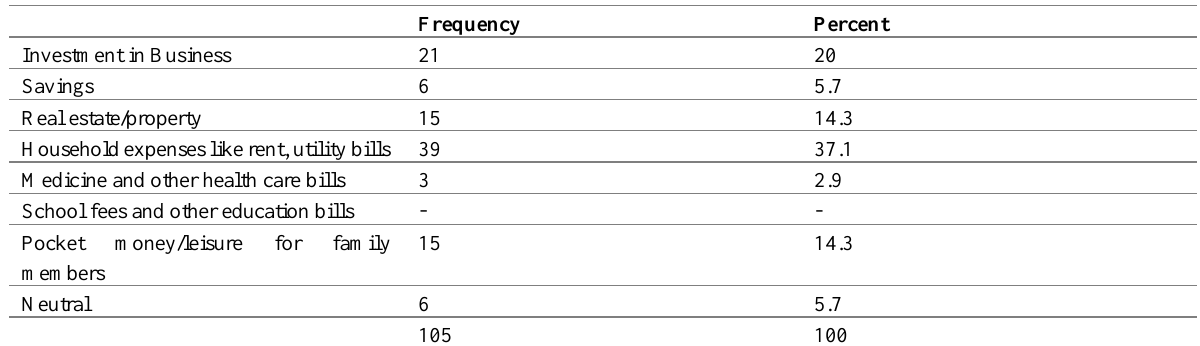
Table 1: Tick the top thing you do with money remitted to